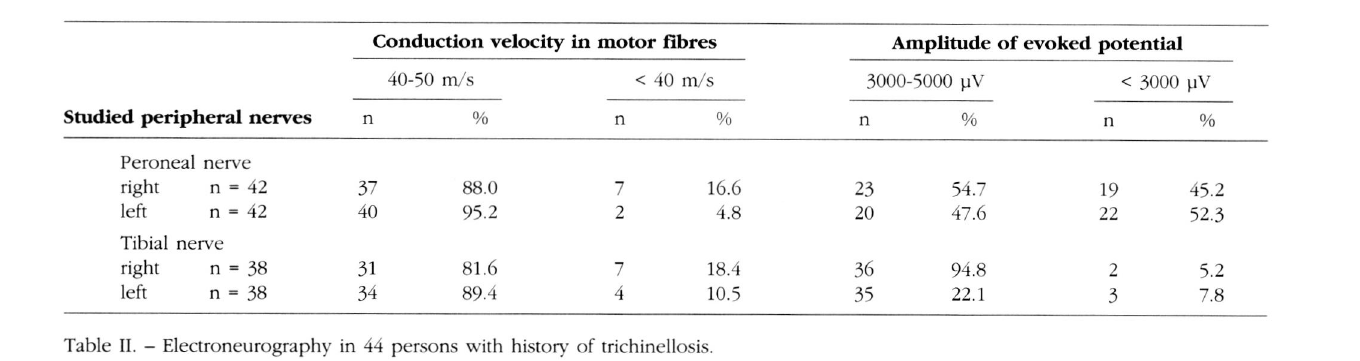
Table II. - Electroneurography in 44 persons with history of